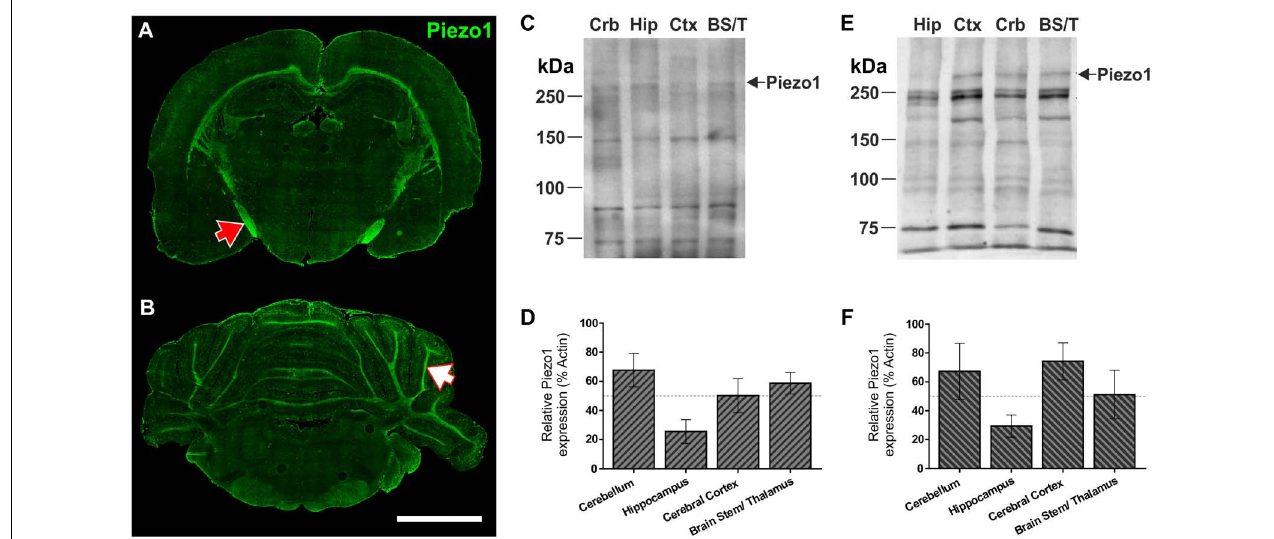
FIGURE 1 | Piezo1 channels are highly expressed by neurons in the optic tract, corpus callosum, and arbor vitae of the cerebellum. Coronal sections of the 5-week old rat brain were cut at –3.3 mm (A) and –10.8 mm (B) with respect to Bregma and immunofluorescently stained for Piezo1 (N-terminal antibody) ( n = 4), scale bar = 4,000 µ m. The red arrow points to the optic tract in the right hemisphere and the white arrow points to the arbor vitae of the Ansiform lobule Crus 1 of the cerebellum. 5-week old rat brains were also dissected into four parts for Western blotting (WB), i.e., cerebellum (Crb), hippocampus (Hip), cerebral cortex (Ctx) and brainstem/thalamus (BS/T). WB were run for Piezo1 using an N-terminal binding antibody (C,D) from Santa Cruz ( n = 3) and a C-terminal binding antibody (E,F) from Abcam ( n = 3). The hippocampus consistently showed the lowest levels of Piezo1 protein